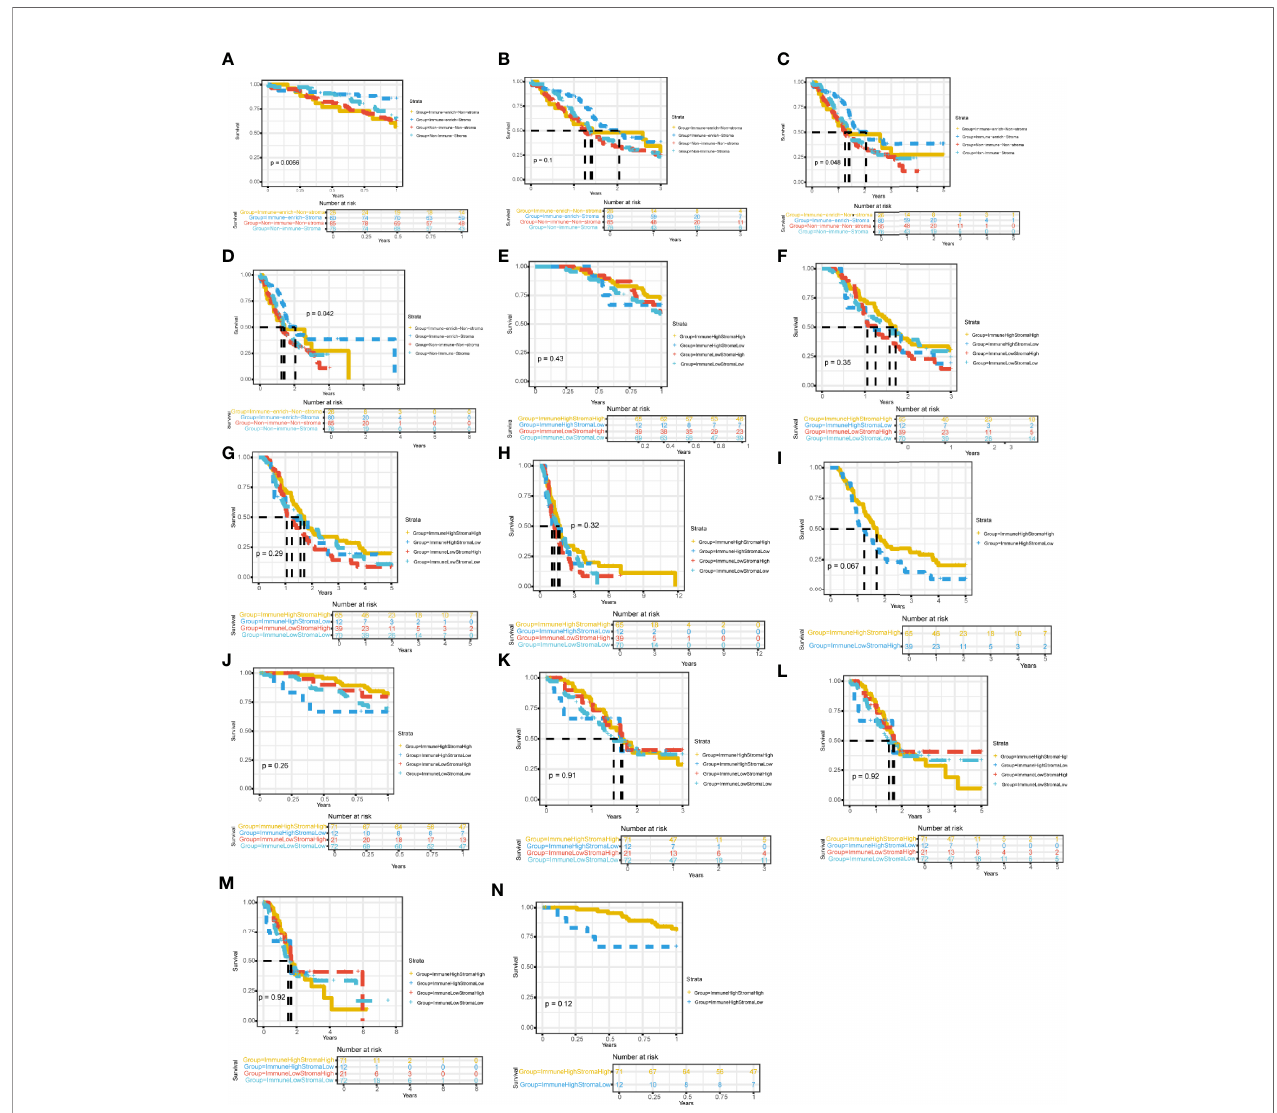
FIGURE 3 | Four immune subtypes are related to clinical characteristics and survival prognosis Comparison of survival rates between subgroups in different cohorts (A) Comparison of 1-year survival rate of PACA-AU cohort. (B) Comparison of 3-year survival rate of PACA-AU cohort. (C) Comparison of 5-year survival rate of PACA-AU cohort. (D) Comparison of survival rates of all PACA-AU cohort. (E) Comparison of 1-year survival rate of PACA-CA cohort. (F) Comparison of 3-year survival rate of PACA-CA cohort. (G) Comparison of 5-year survival rate of PACA-CA cohort. (H) Comparison of survival rates of all PACA-CA cohort. (I) Comparison of survival rates of the Immune-enrich-Stroma and Non-immune-Stromasubtypes. (J) Comparison of 1-year survival rate of TCGA-PAAD cohort. (K) Comparison of 3-year survival rate of TCGA-PAAD cohort. (L) Comparison of 5-year survival rate of TCGA-PAAD cohort. (M) Comparison of survival rates of all TCGA-PAAD cohort. (N) Comparison of survival rates of the Immune-enrich-Stroma and Immune-enrich-non-Stroma